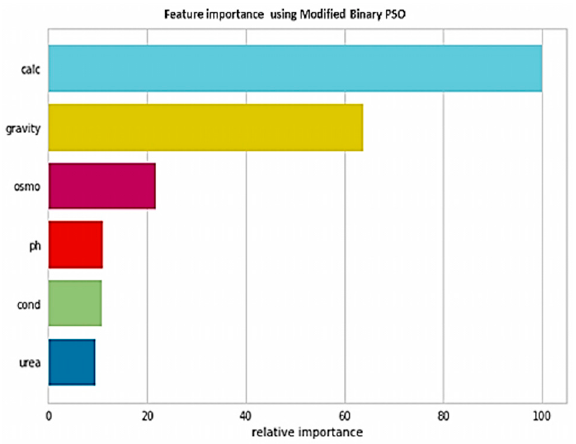
Figure 8. Feature importance of MBPSO.